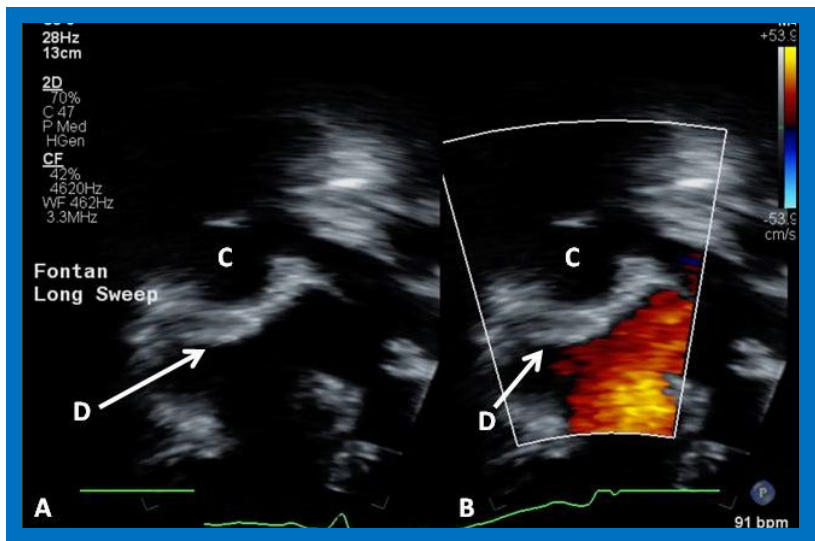
Figure 56. Selected video frames from apical four chamber view, demonstrating the position of the Amplatzer device (D) (arrows in ( A , B )). No residual shunt is seen ( B ). C, conduit. See Figure 57 for the angiographic counterpart.